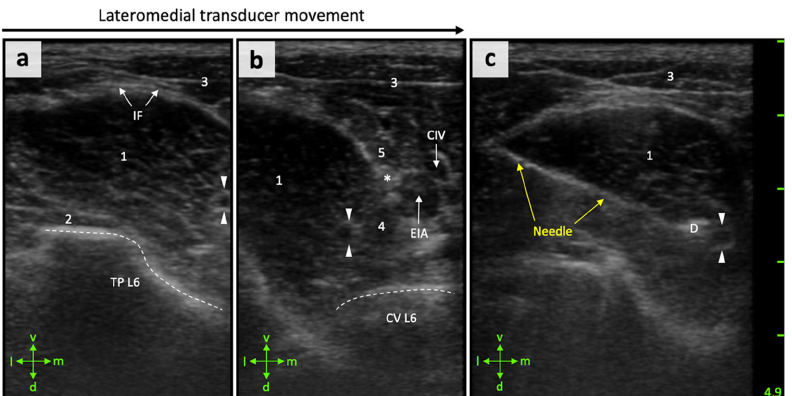
Figure 3. Transversal ultrasound images showing sonoanatomical reference structures and perineural injection of a right femoral nerve. ( a ) Lateral aspect, ( b ) medial aspect, and ( c ) with the inserted needle in plane. IF, iliac fascia; TP L6, transverse process of the sixth lumbar vertebra (bone surface = dashed line); CV L6, vertebral corpus of L6 (bone surface = dashed line); CIV, common iliac vein; EIA, external iliac artery; D, dye; femoral nerve (arrowheads); 1 = psoas major muscle; 2 = quadratus lumborum muscle; 3 = abdominal wall muscles; 4 = medial part of iliac muscle; 5 = psoas minor muscle and its tendon (asterisk); l, lateral; m, medial; v, ventral; d, dorsal. Depth marks (1 cm) apply to images a–c.